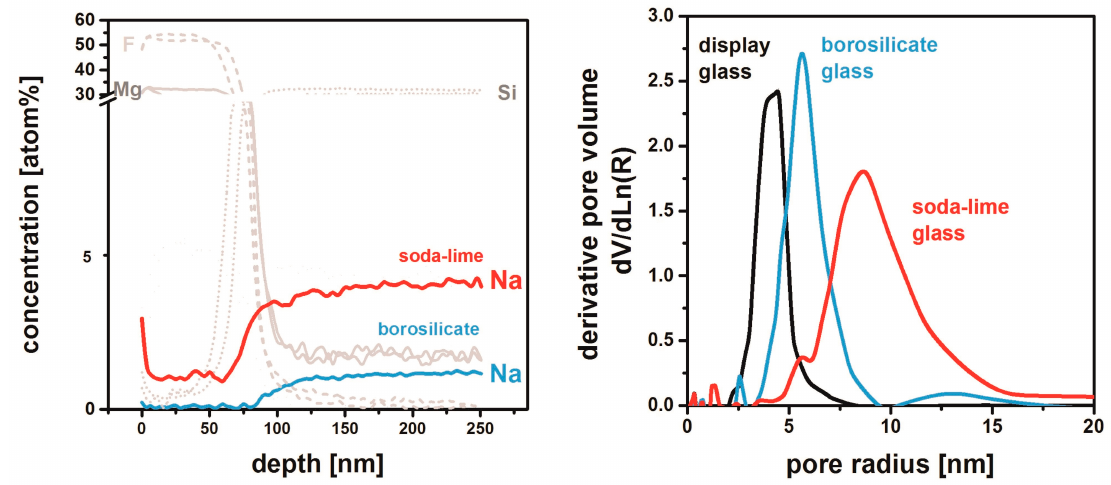
Figure 12. XPS depth profile of MgF 2 films deposited on soda-lime and borosilicate glass ( left ) and pore radius distributions of samples on different glasses as measured by EP ( right ). All films have been thermally treated at 500 °C. Based on [51].